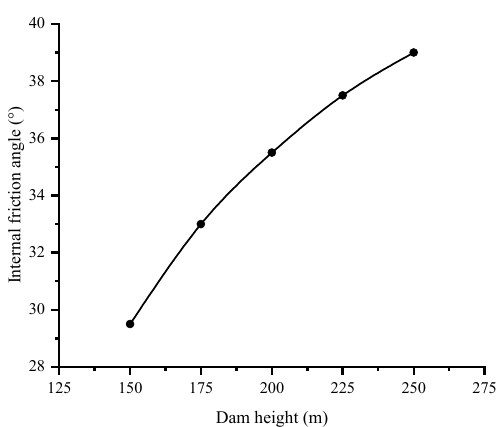
Figure 14. Relationship between internal friction angle of ACC that meets YSFCS and dam height.